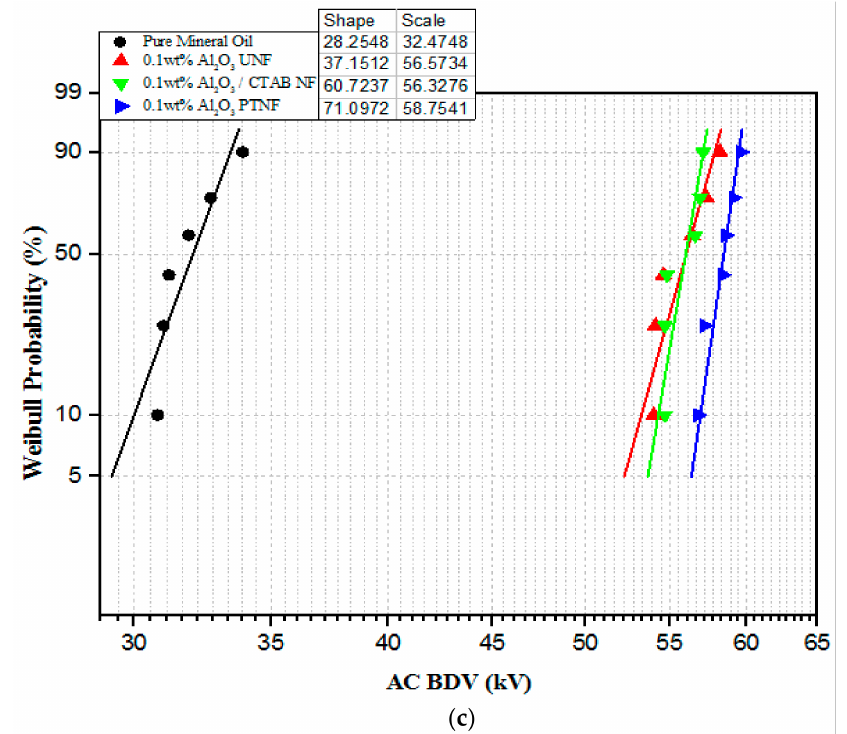
Figure 6. Weibull analyses of AC breakdown voltages; ( a ) MO + Al 2 O 3 untreated nanofluids, ( b ) MO